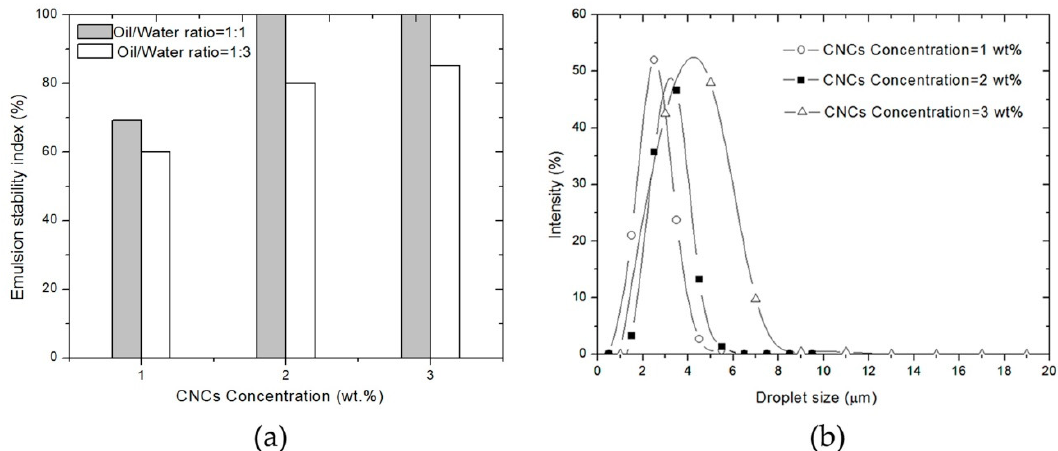
Figure 5. ( a ) Effect of concentration of CNCs on emulsion stability index; ( b ) droplet distributions of emulsions prepared at different CNCs concentration with a fixed oil to water ratio at 1:1.